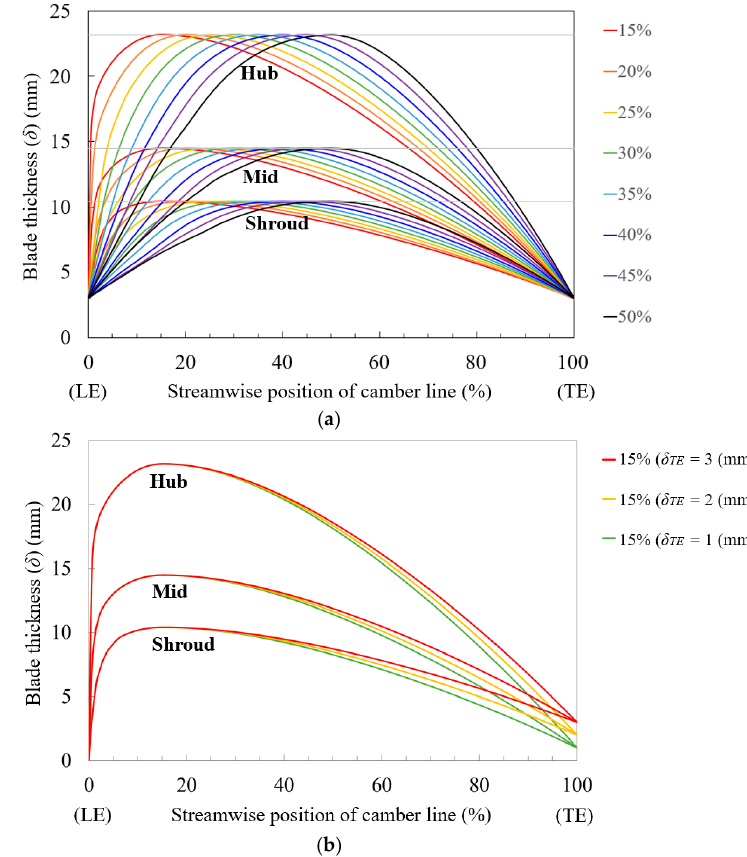
Figure 3. Thickness profiles of airfoil with variation in ( a ) maximum thickness position and ( b ) trailing edge thickness treatment.